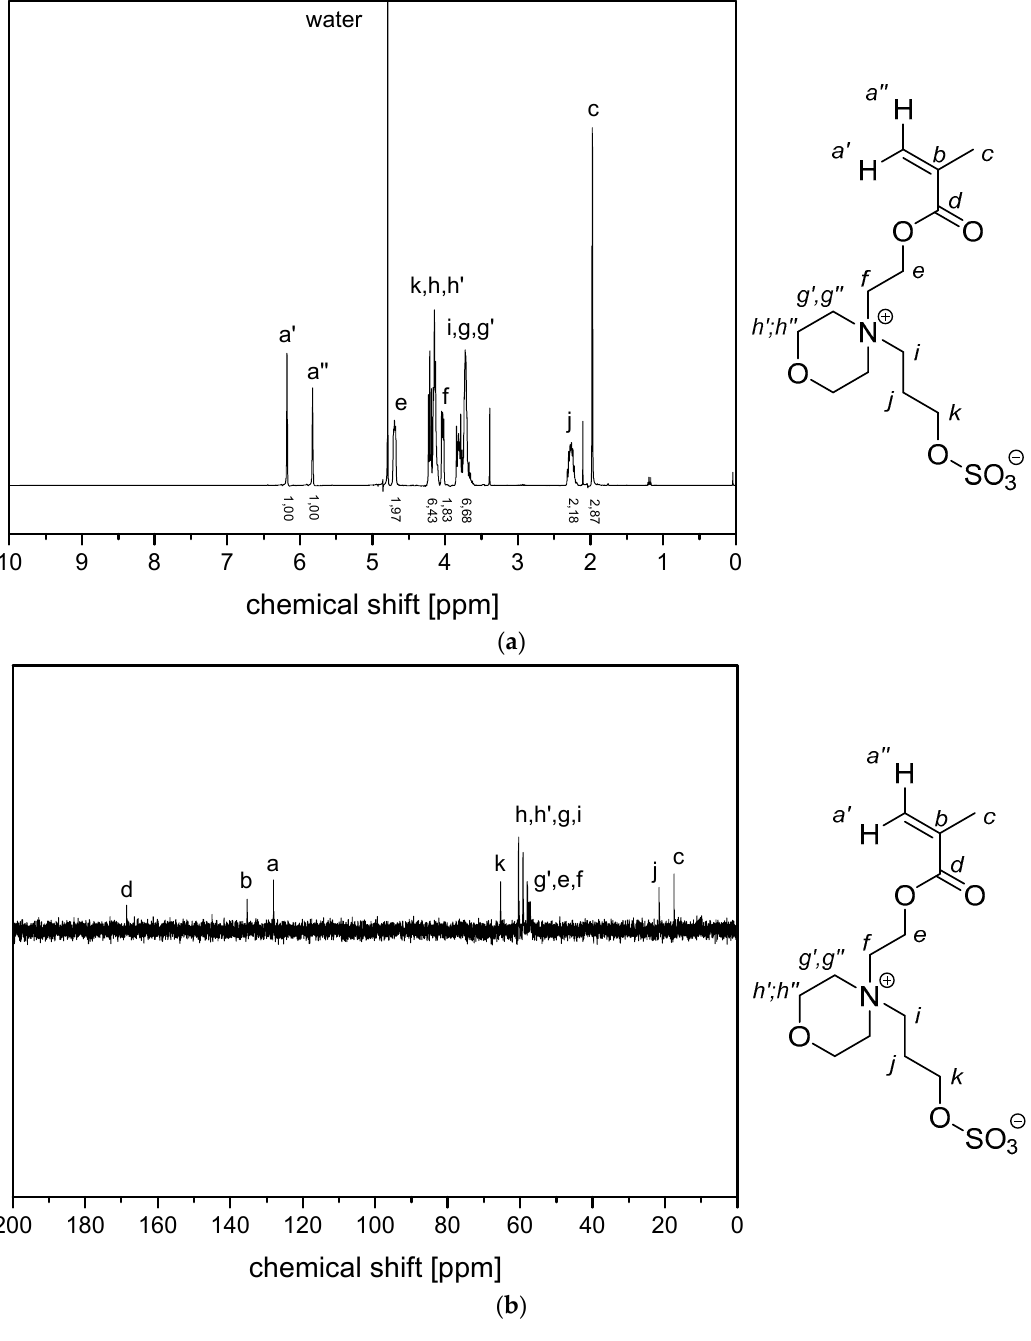
Figure A11. ( a ) 1 H NMR- spectra and ( b ) 13 C (APT) NMR-spectra of monomer 5d in D 2 O.